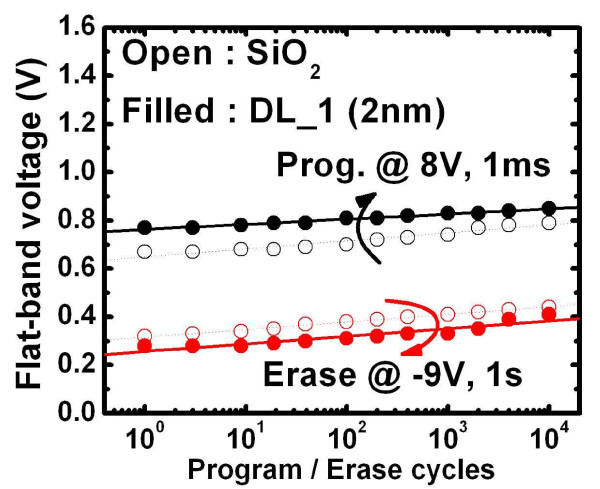
Endurance characteristics. The endurance characteristic to 104 cycles operation for Gd2O3-NC memories with nanostructure (DL_1 (2 nm)) and single (SiO2) tunneling layer. The P/E conditions are 8 V, 1 ms and -9 V, 1 s, respectively.